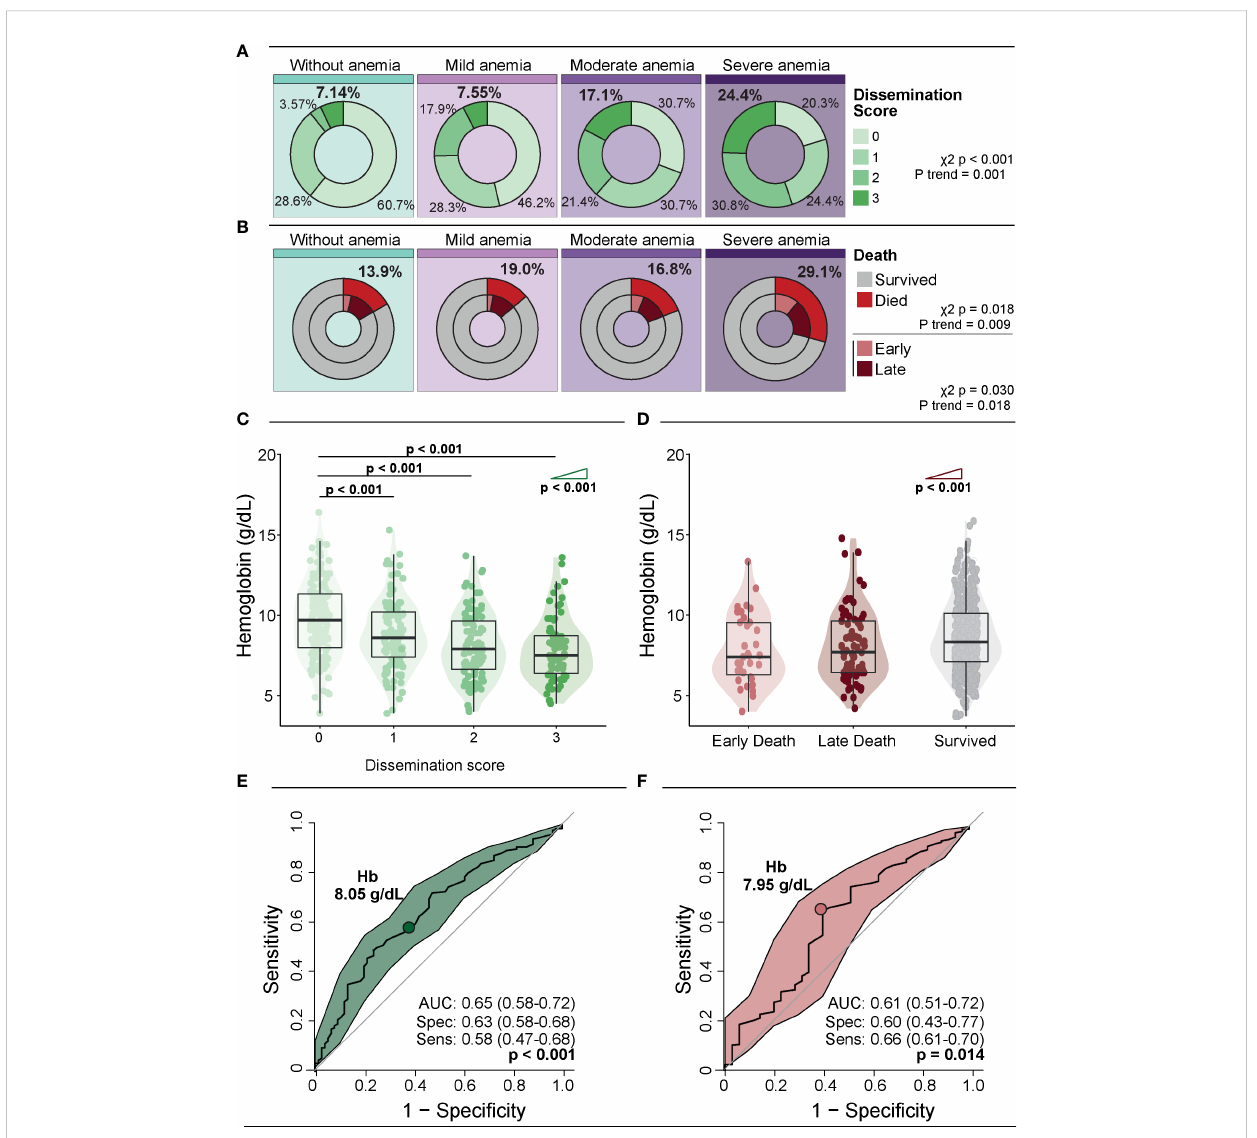
FIGURE 1 Association of anemia severity with Mtb dissemination and death. (A) Distribution of dissemination score according to anemia severity. (B) Distribution of deaths and time to death according to anemia severity. Early deaths were de fi ned as deaths occurring within 7 days of enrolment, and late deaths were all deaths that occurred after 7 days and within 12 weeks of enrolment. (C) Hb levels according to dissemination score. (D) Hb levels according to time of death. Groups were compared using the Mann – Whitney U test. The Cochran – Armitage test for trend was used to assess the tendency of increased levels or frequencies among groups. (E, F) ROC curve analysis was used to evaluate the accuracy of Hb values to discriminate high dissemination score (Mtb dissemination score 3) (E) and early death (F) . Colored dots indicate the cut-off values of Hb extracted from the ROC curve analyses that resulted in the optimal ratio between sensitivity and speci fi city; these values are described in the indicated panels. Mild anemia was de fi ned as Hb value >10 g/dL and <13 g/dL for men; and >10 and <12 g/dL for women, whereas moderate anemia was de fi ned as Hb>8 g/dL and <=10 g/dL for both sexes. Severe anemia was de fi ned as Hb<8g/dL for both